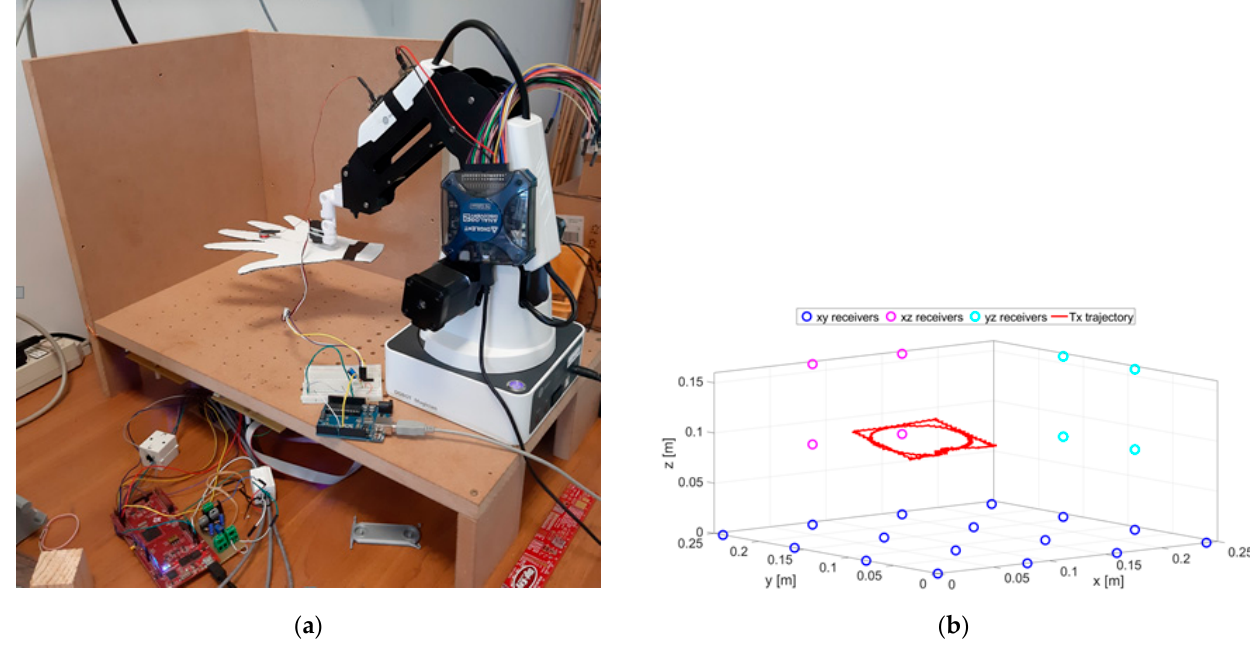
Figure 3. A picture of the experimental setup ( a ) and schematic representation of the RX positions and an example of the TX trajectory ( b ).